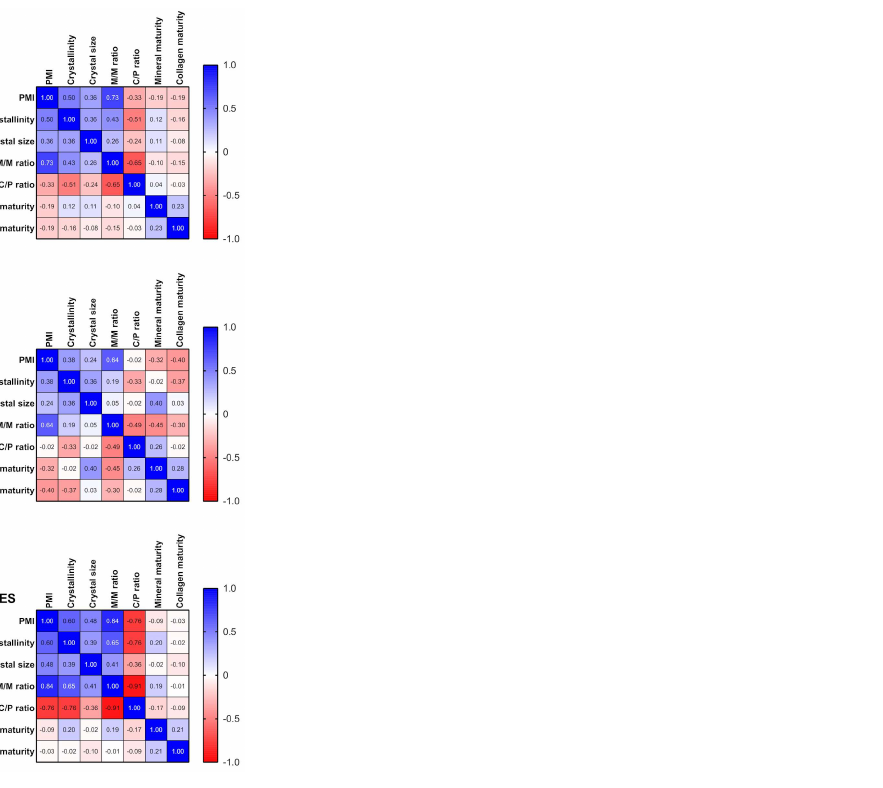
Figure 3. Correlation analysis between PMI, crystallographic indices and tooth compounds. ( A ): Correlation analysis between PMI, crystallographic indices and tooth compounds in the total sample. ( B ): Correlation analysis between PMI, crystallographic indices and tooth compounds in males. ( C ): Correlation analysis between PMI, crystallographic indices and tooth compounds in females.